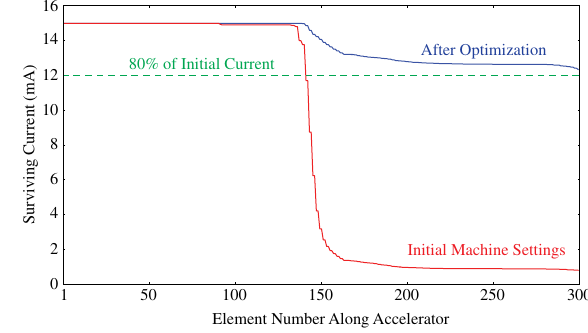
FIG. 12. Surviving beam current along the machine with 2011 tune-based magnet settings and arbitrary phase (red) and follow- ing RR tune (blue).